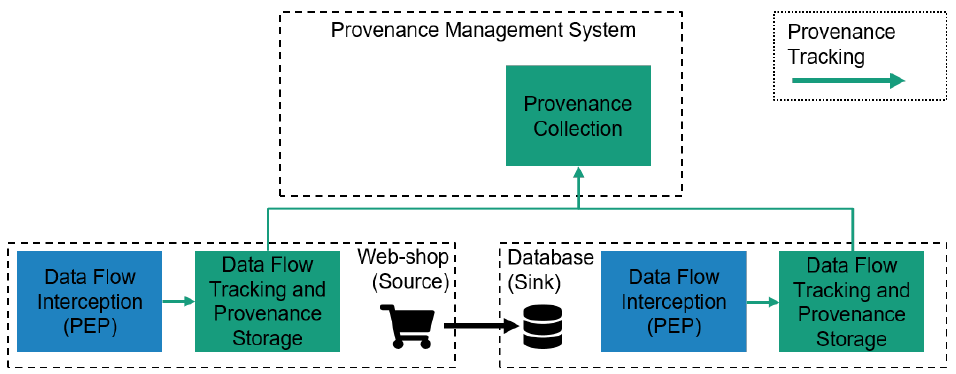
Figure 1. An exemplary data provenance tracking